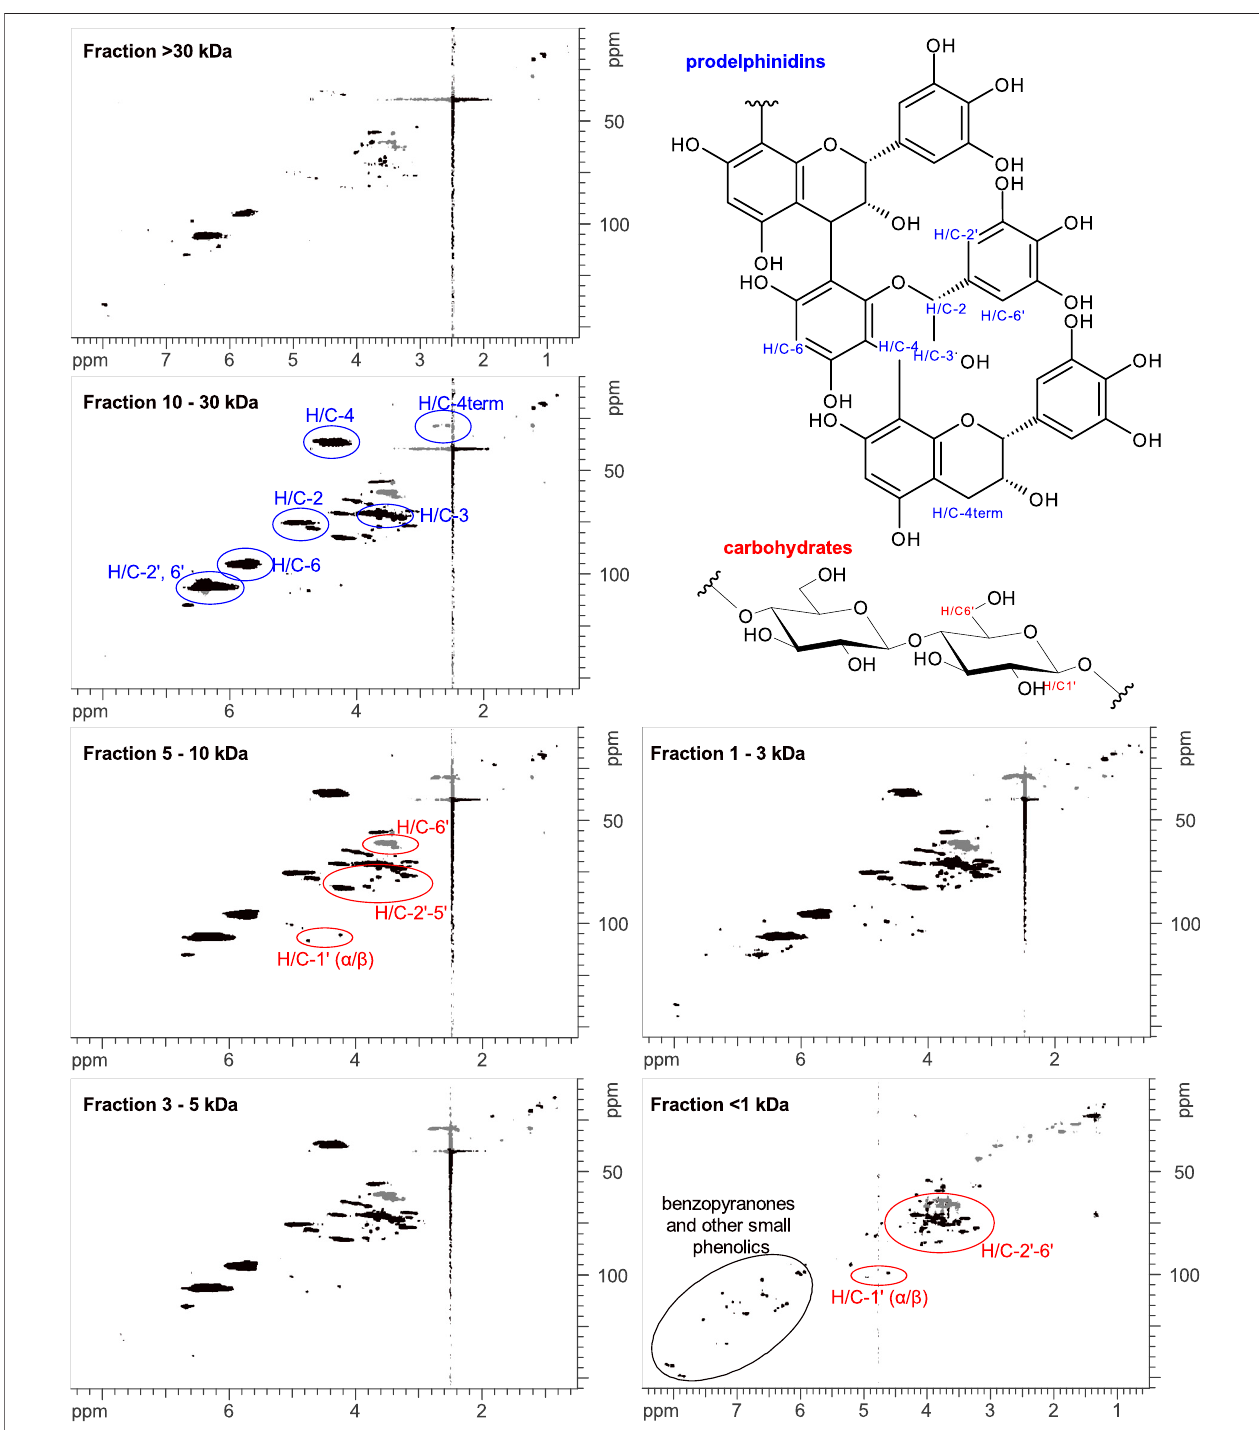
FIGURE 3 | 1H-13C-HSQC-NMR spectra of EPs 7630 fractions. Assignments to prodelphinidins (blue), carbohydrates (red), and small phenolics like benzopyranones (black) are color-coded. In the fraction > 30 kDa some sharp signals of umckalin (sulfate) and broad signals of polymeric prodelphinidins and carbohydrates are observable. In the fractions 1 – 30 kDa, oligomeric prodelphinidins and carbohydrates are detectable as broad signals, with only minor amounts of sharp signals of small molecules. In the fraction < 1 kDa, only sharp signals of small molecules are detectable, which can be assigned to typical resonances of phenolic and carbohydrate signal patterns. In this < 1 kDa fraction, no signals of prodelphinidins are detectable.